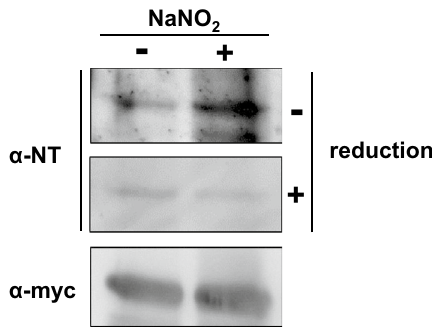
Figure 2. PTN modification of Pdc1 in response to RNS. The PDC1-myc7His strain grown until the exponential phase was treated with acidified nitrite and then the extracted lysate was subjected to pull-down assay, followed by western blot analysis with anti-NT or anti-myc antibody. The PVDF membrane was incubated with sodium dithionite before the treatment with anti-NT antibody as a negative control for the PTN analysis.